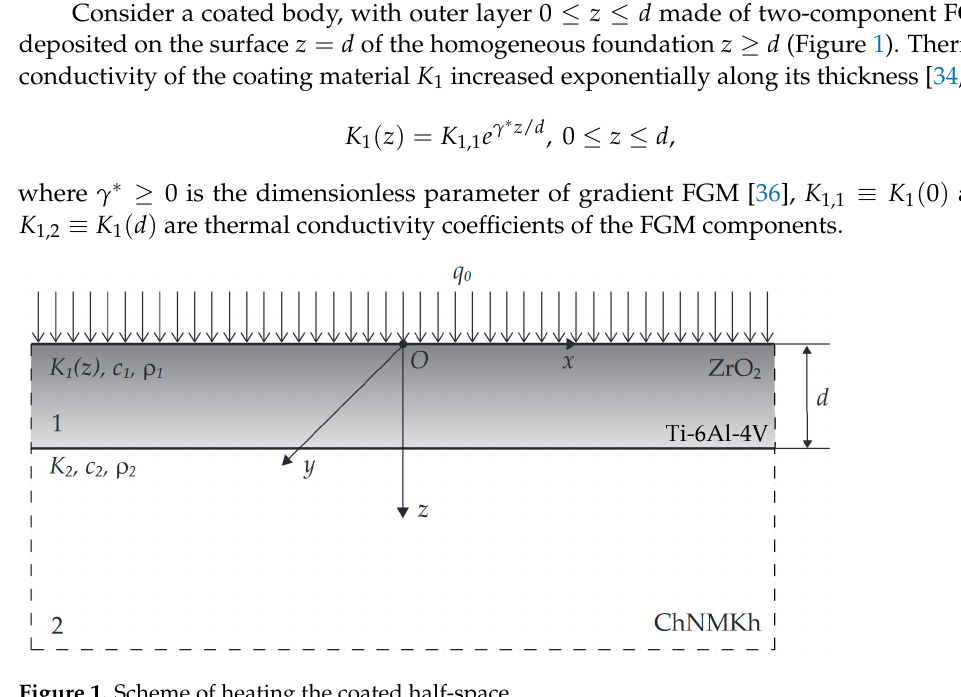
Figure 1. Scheme of heating the coated half-space.